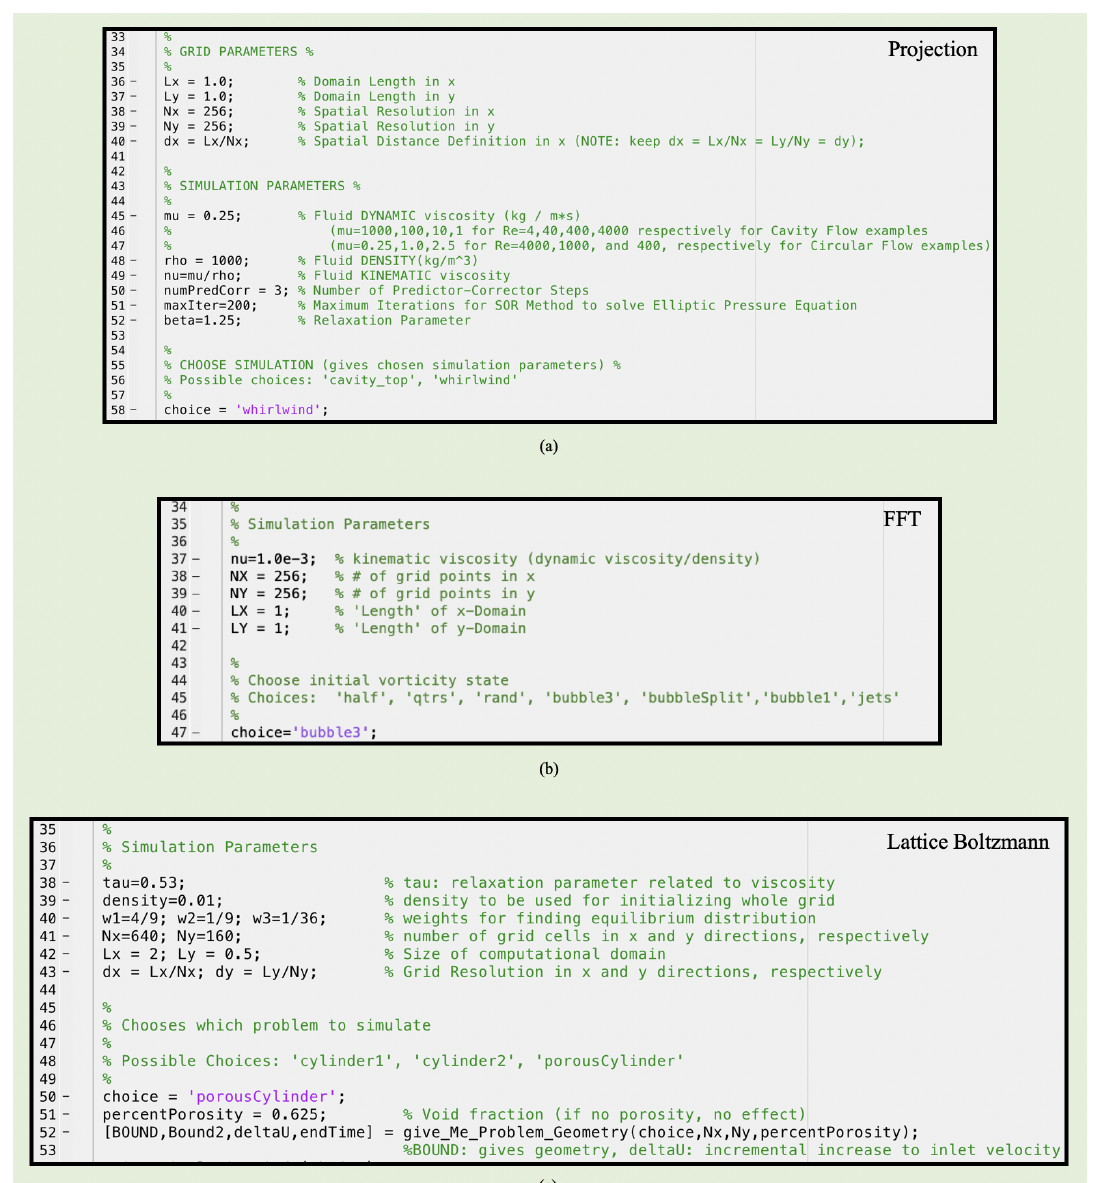
Figure 3. Options for practitioners to change the grid resolution and size, fluid properties (density, viscosity), and other solver attributes within the software for the ( a ) Projection method, ( b ) Fast Fourier Transform (FFT)-based spectral solver, and ( c ) Lattice Boltzmann solver. The possible choices for built-in examples are also listed for